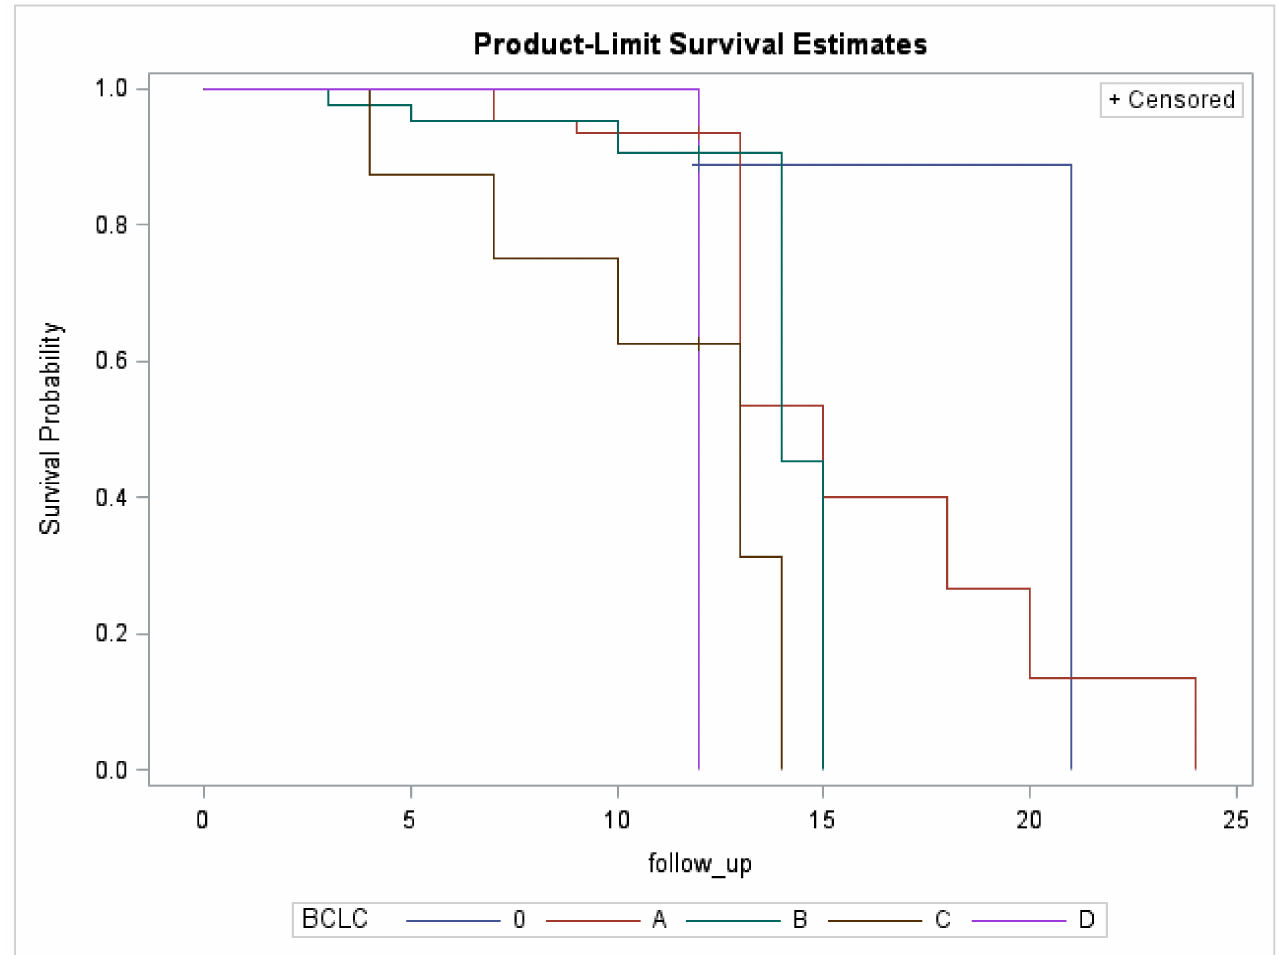
Figure 1. Survival rates of patients according to BCLC staging.